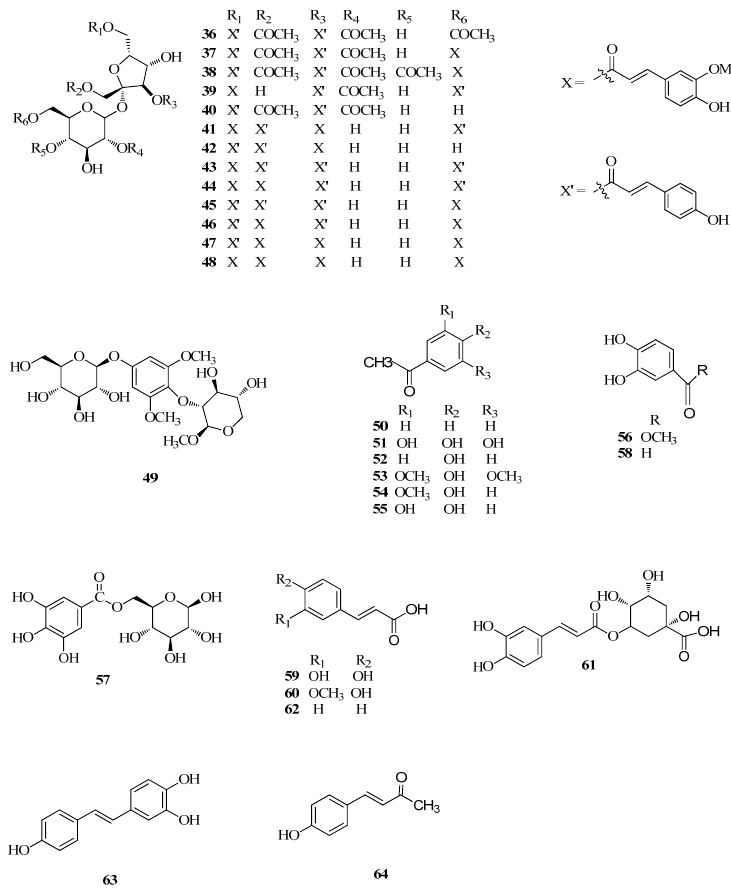
Figure 3. Structures of phenolic compounds isolated from F. esculentum , F. tataricum and F. diabotrys .